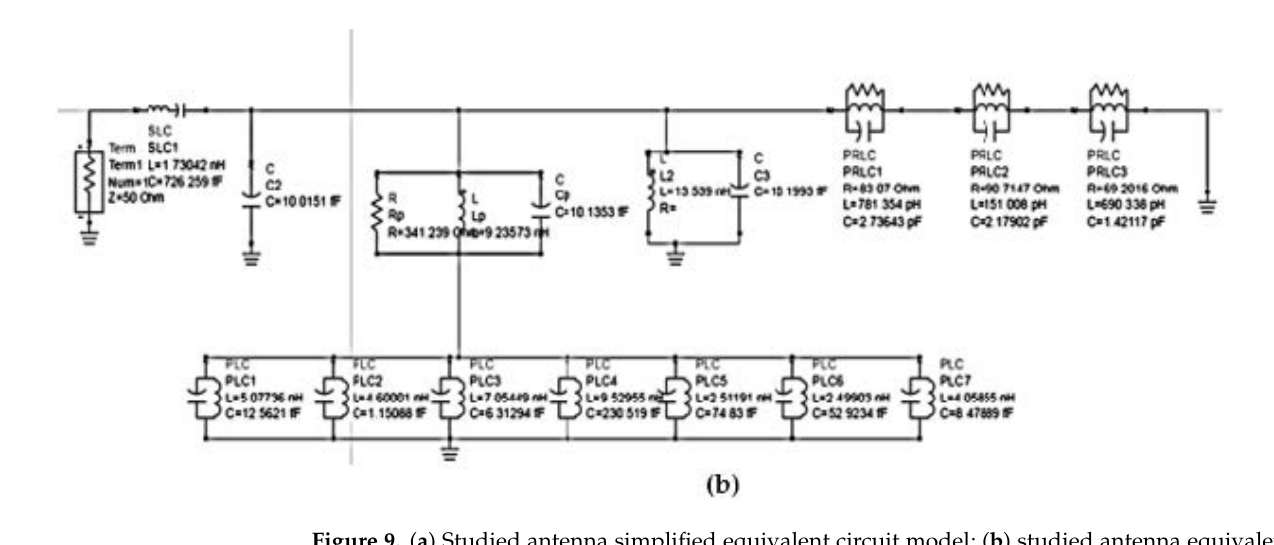
Figure 9. ( a ) Studied antenna simplified equivalent circuit model; ( b ) studied antenna equivalent circuit model computed under ADS. circuit model computed under ADS.